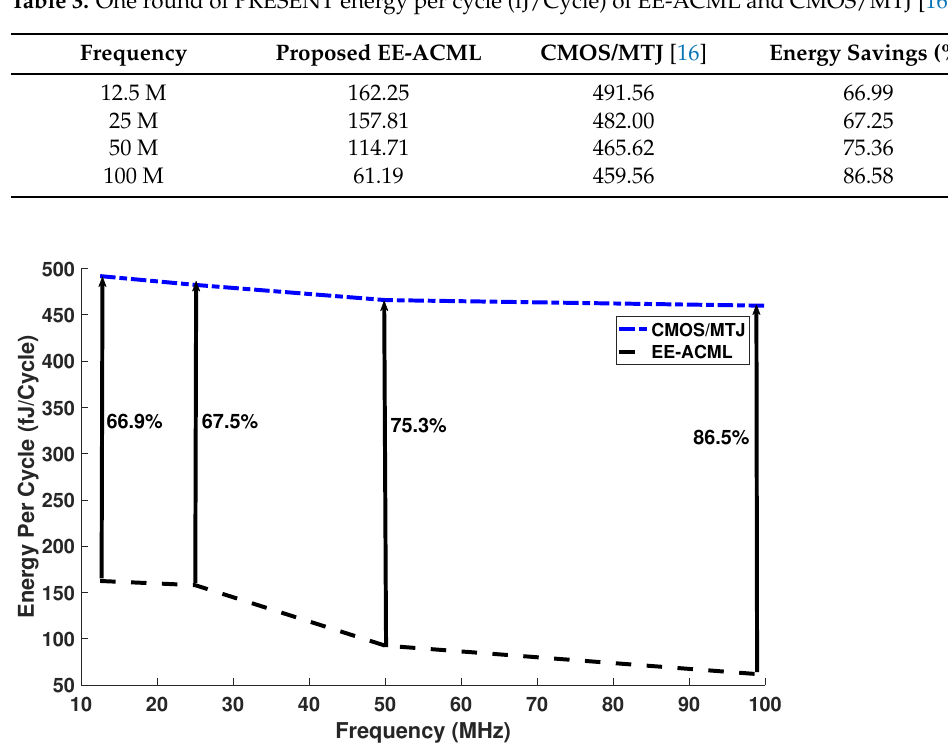
Figure 14. Energy per cycle comparison between proposed EE-ACML and